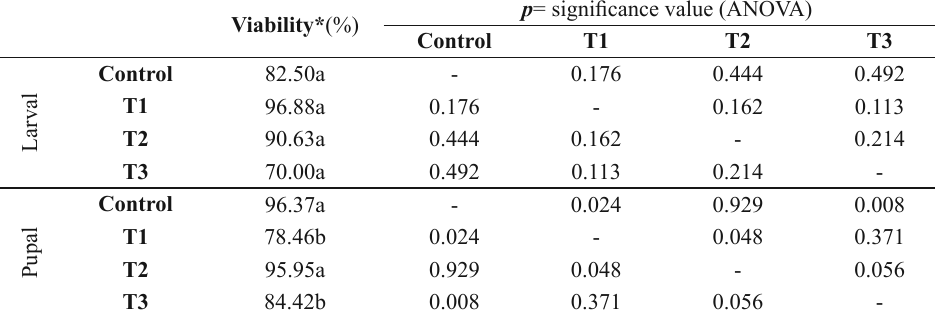
ANOVA comparison of the viability of larvae, pupae and total (L1 to adult) of Chrysomya putoria (Wiedemann, 1830) subjected to four treatments: control = gizzard homogenate agar; T1 = gizzard homogenate agar + ampicillin 41.66 μ g/mL, T2 = gizzard homogenate agar + ampicillin 81.33 μ